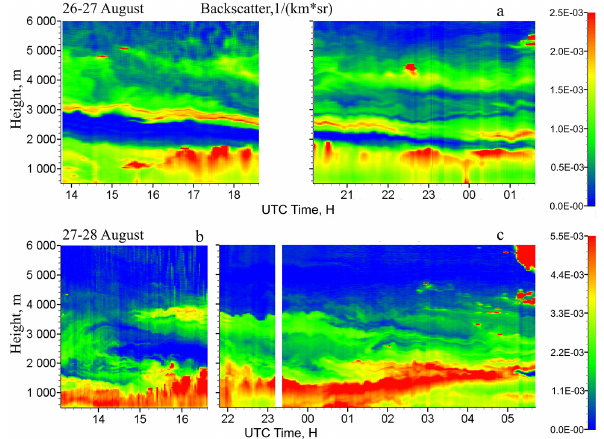
Figure 1. Backscattering coefficients at 355nm calculated from Ra- man lidar measurements on 26–28 August 2013.